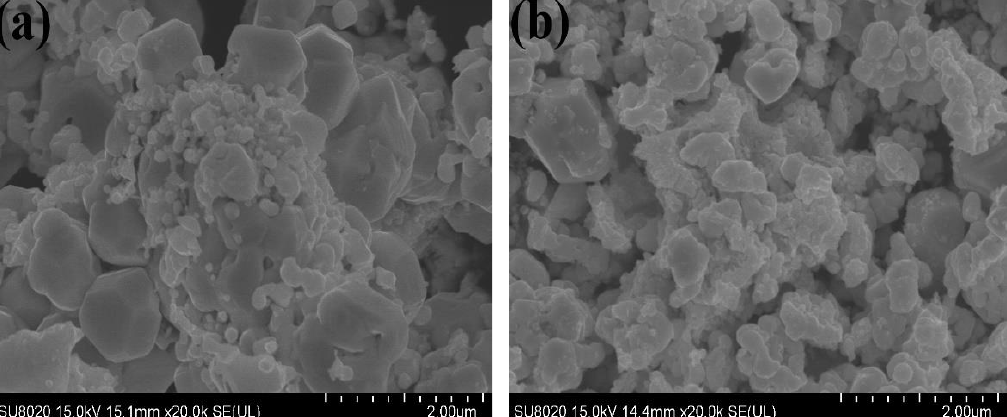
Figure 1. SEM micrographs showing surface morphology of reduced powder: ( a ) W-1wt%TiC, ( b ) W-1wt%ZiC.